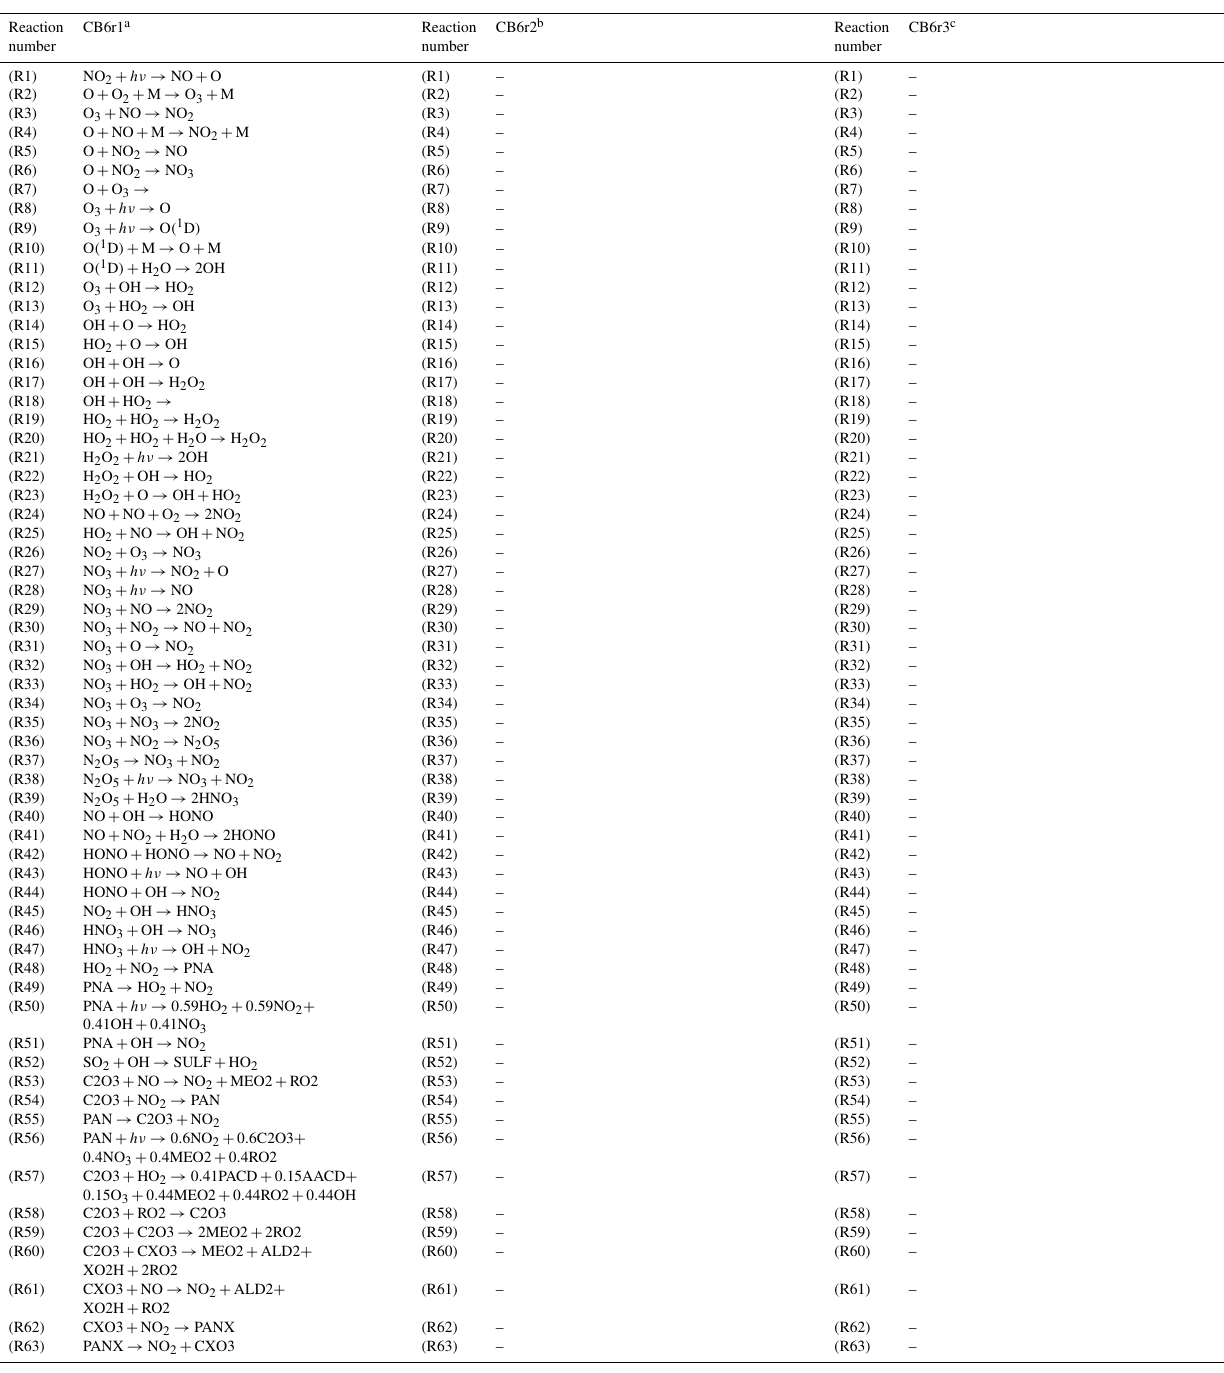
Table A1. Complete listings of chemical reactions belonging to different CB6 mechanisms used in the present study. The updates between different versions of the CB6 mechanism are also marked. The abbreviation “–” denotes that there is no change in the form of this reaction between different CB6